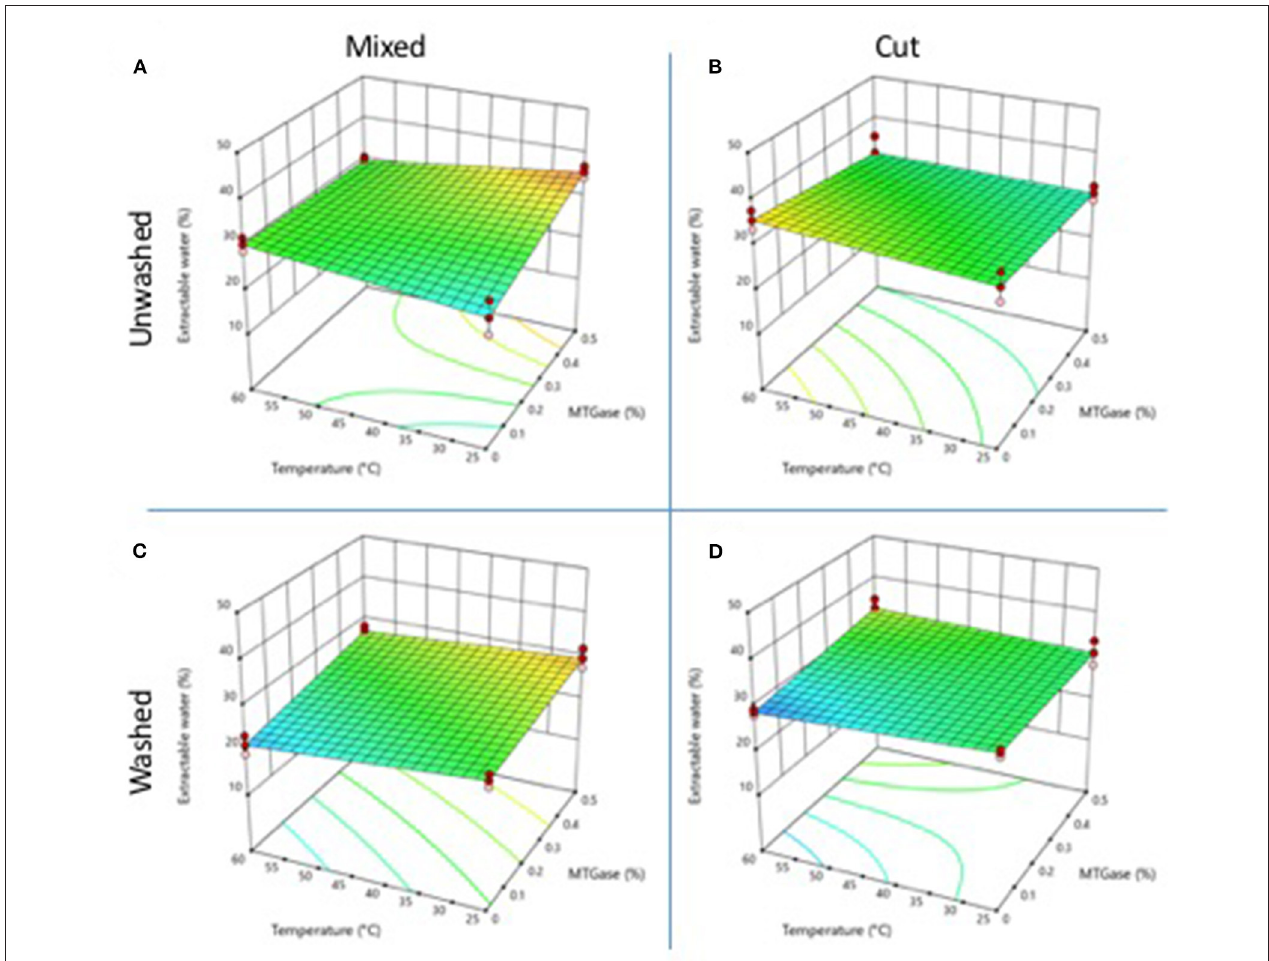
FIGURE 5 | Changes in gel extractable water properties as a function of the type and temperature mixing method, washing of the cooked meat, and adding of MTGase. (A) Mixed-unwashed samples, (B) Cut-unwashed samples, (C) Mixed-washed samples, and (D) Cut-washed